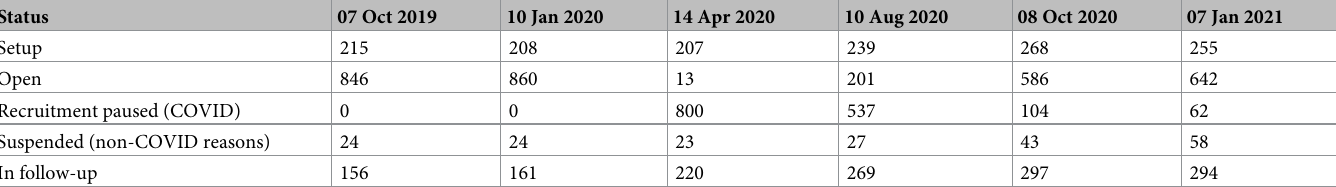
Table 3. Status of non-commercial